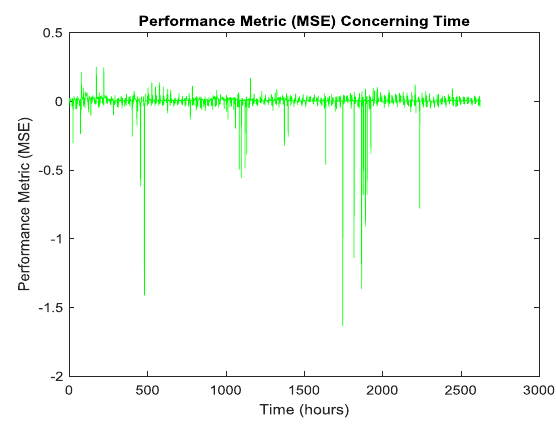
Fig. 4. Performance Metric (MSE) concerning the time. Table 3. Proposed EIBPNN performance compared with other prediction